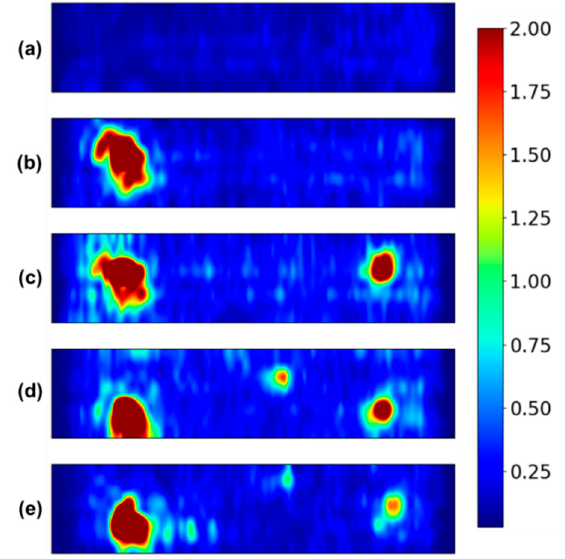
Figure 9. Normalized non-propagating wave energy maps 𝐸 (cid:3015)(cid:3017)(cid:3016)(cid:3015) (𝑥,𝑦) : ( a ) Case 0 (pristine), ( b ) Case 1 (D1 only), ( c ) Case 2 (D1 and D2), ( d ) Case 3 (D1 to D3) and ( e ) Case 4 (D1 to D4). Each scan area represents a 250 mm (horizontal) × 49 mm (vertical) scan area.